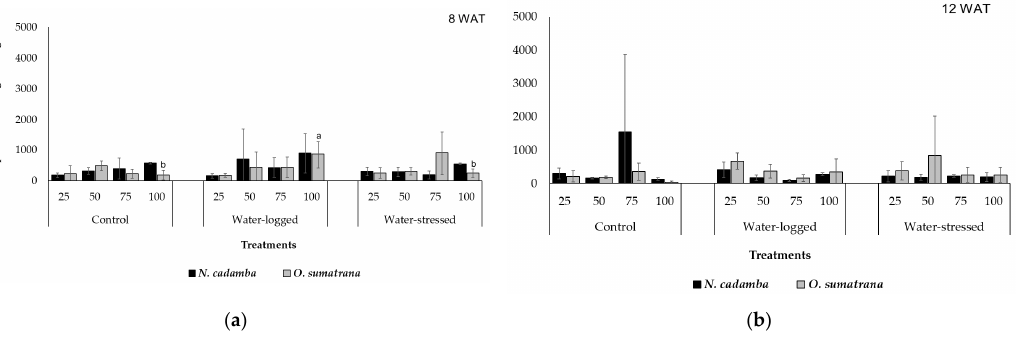
Figure 6. ( a ) Specific Root Length (cm cm − 3 ) at 8 WAT under water-stress, water-logged, and